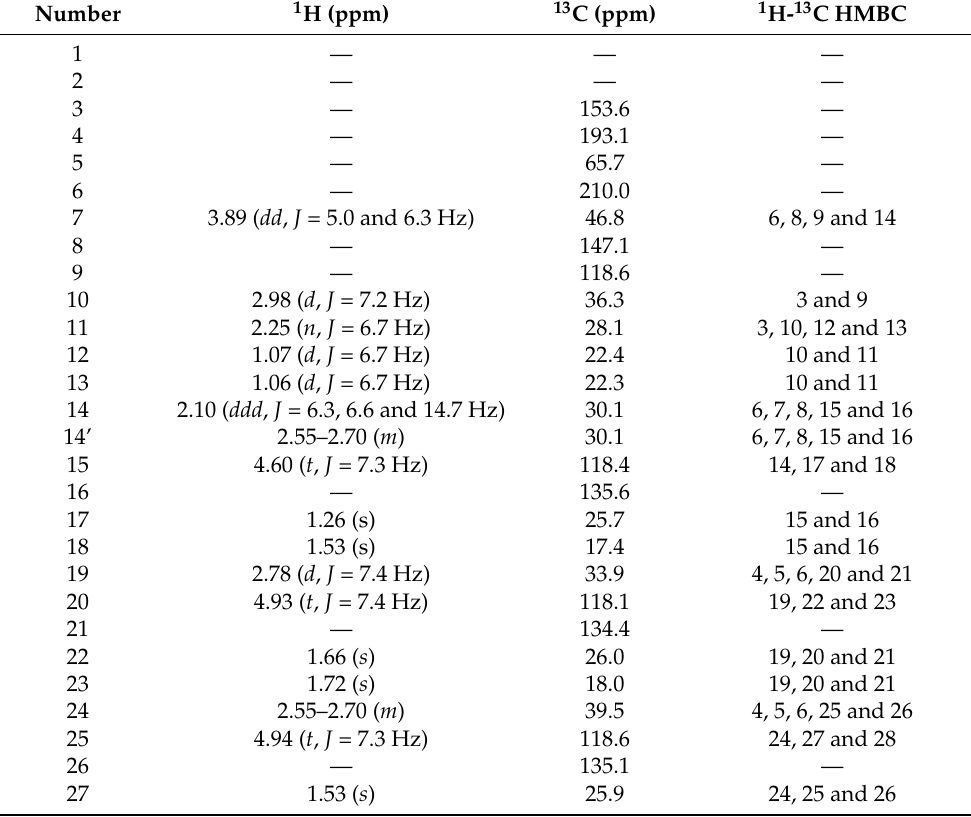
Figure 2. Possible products and full structural assignment of the lupulone derivative 4 . Table 2. 1 H and 13 C chemical shifts, coupling constants, and HMBC 2D correlations of lupulone derivative 4